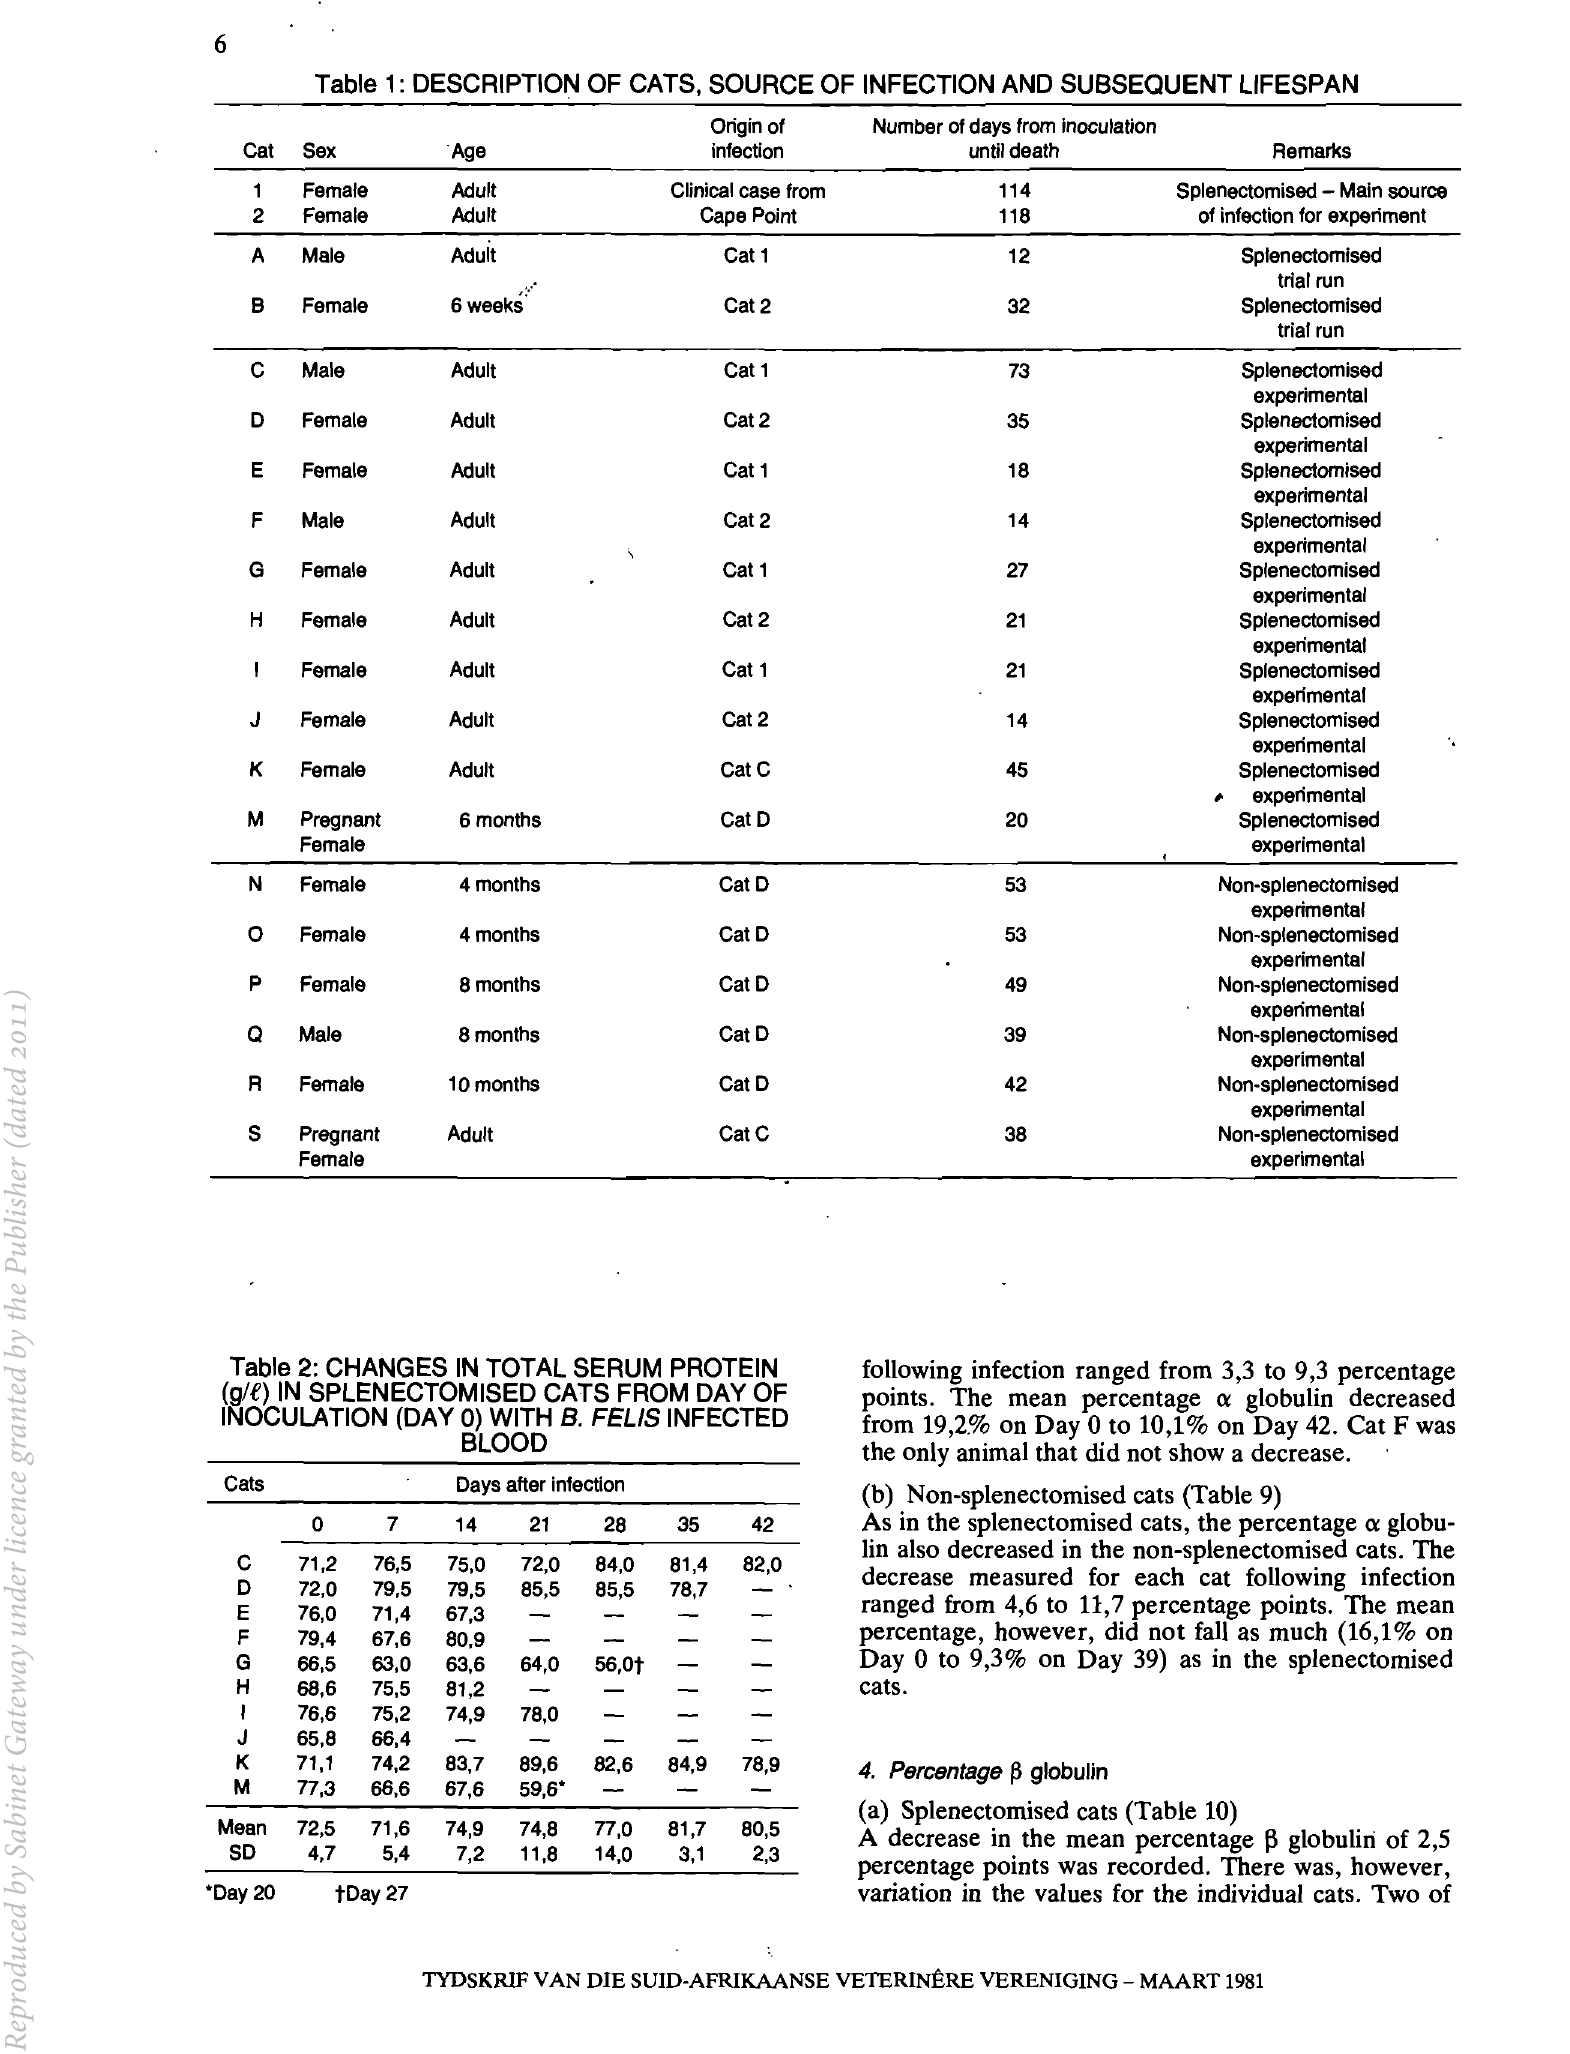
Table 1: DESCRIPTION OF CATS, SOURCE OF INFECTION AND SUBSEQUENT LIFESPAN